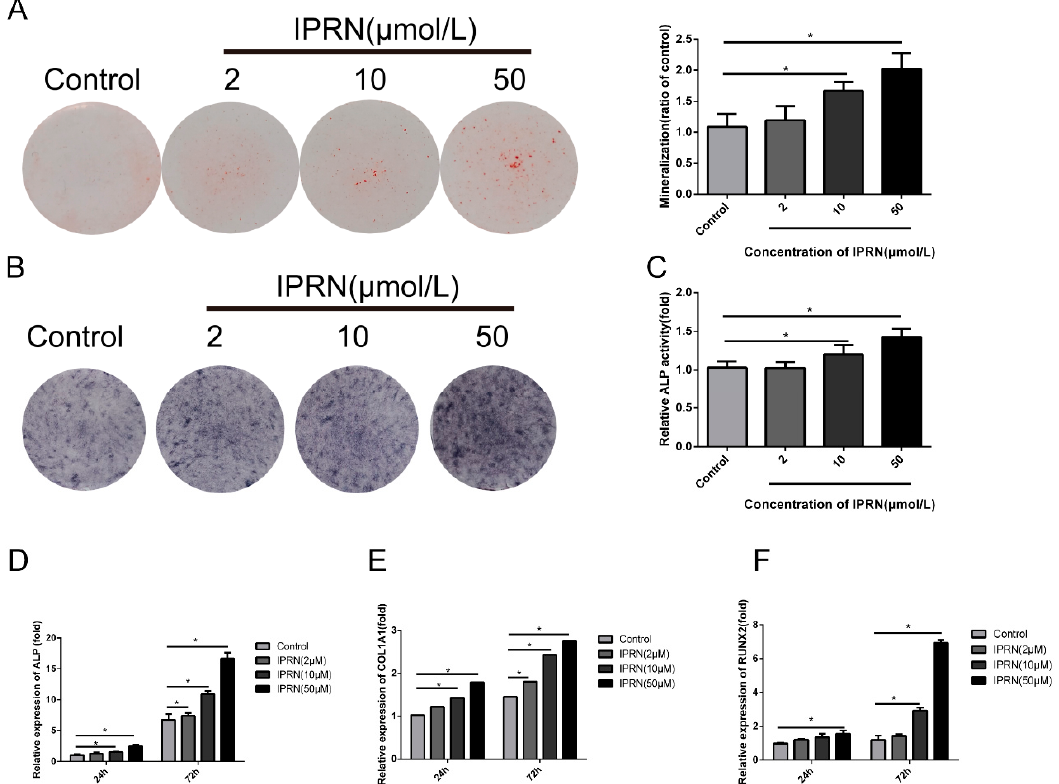
Figure 2. Effects of IPRN on osteoblastic differentiation of MC3T3-E1 cells. Cells were cultured in osteogenic medium with the indicated concentration of IPRN (2–50 µ M) for 14 days ( A ), 9 days ( B , C ) or 24 and 72 h ( D – F ). ( A ) Alizarin red staining was performed to assess mineralization, and the cells were then solubilized with 10% cetylpyridinium chloride and quantified at 562 nm. Differentiation was assessed by alkaline phosphatase (ALP) staining ( B ), ALP activity ( C ) and the mRNA expression of the osteogenic markers ALP ( D ), collagen type I alpha 1 chain ( COL1A1 ) ( E ), and runt-related transcription factor 2 ( RUNX2 ) ( F ). Data are presented as the mean ± standard deviation (SD) ( n = 3).